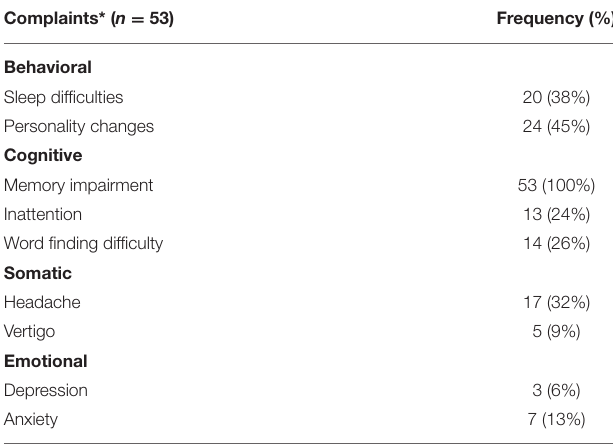
TABLE 2 | Description of